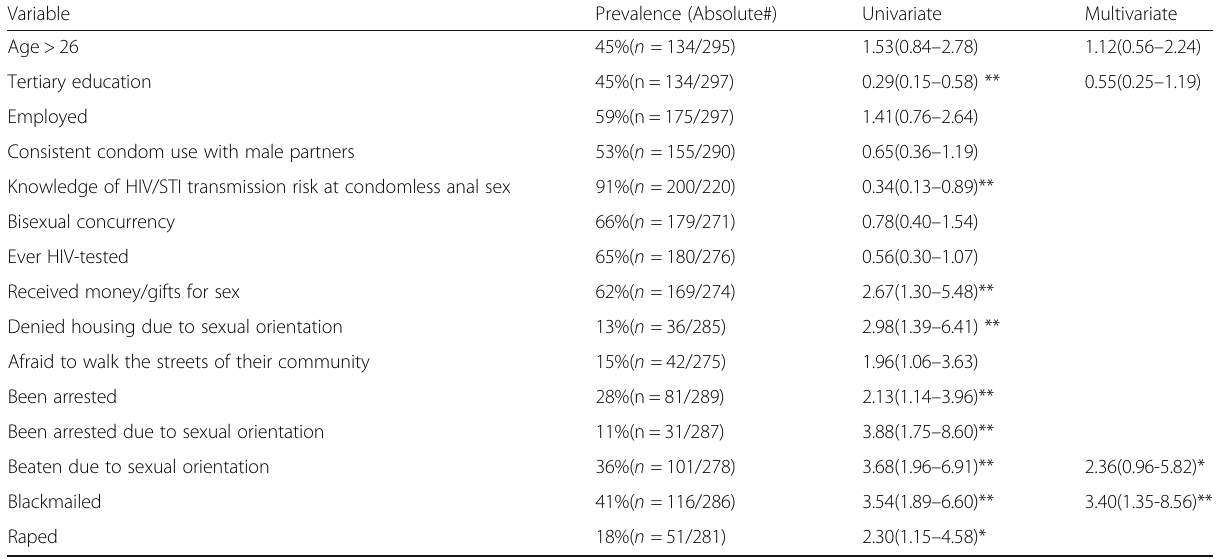
Table 4 Associations of genital ulcer in previous 12 months among MSM in